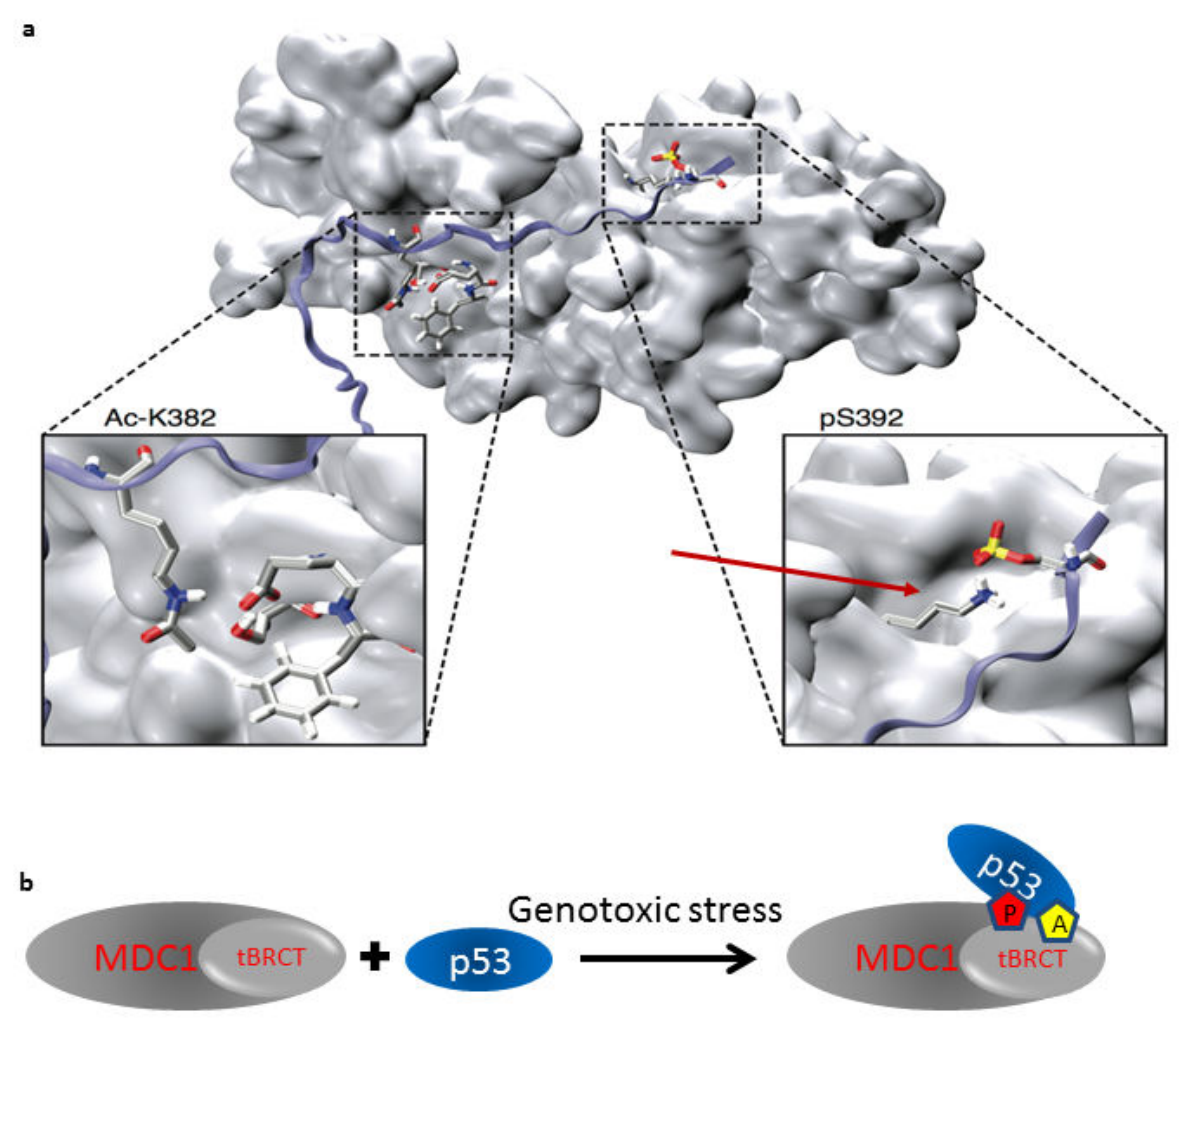
Figure 6. Suggested model and visualization of the p53-MDC1 interaction. (a) MD derived interactions. tBRCT is shown in surface representation in light gray and the p53 CTD peptide is shown as a blue ribbon. Zoom-in panels of the Ac-K382 and pS392 are shown below; note that in the zoom-in panels the viewer angle is slightly rotated for visualization convenience. Red arrow points K1936 in MDC1. (b) Following genotoxic stress p53 (blue) undergoes K382 acetylation (red pentagon) and S392 phosphorylation (yellow pentagon). These residues mediate the interaction with MDC1 (gray) through its tBRCT domain (light gray).